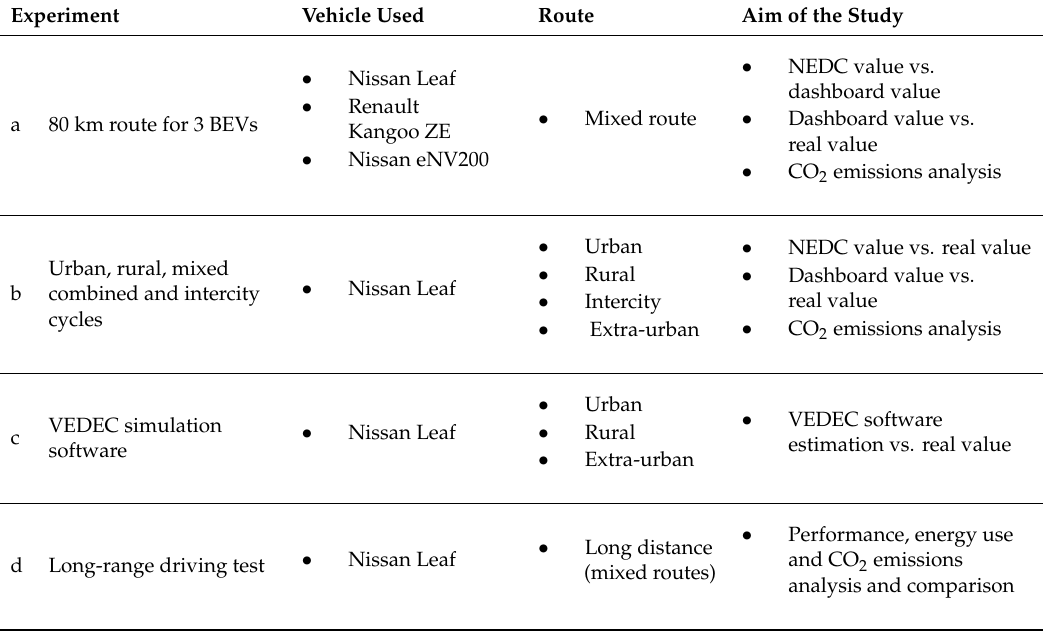
Table 2. Characteristics and objectives of the